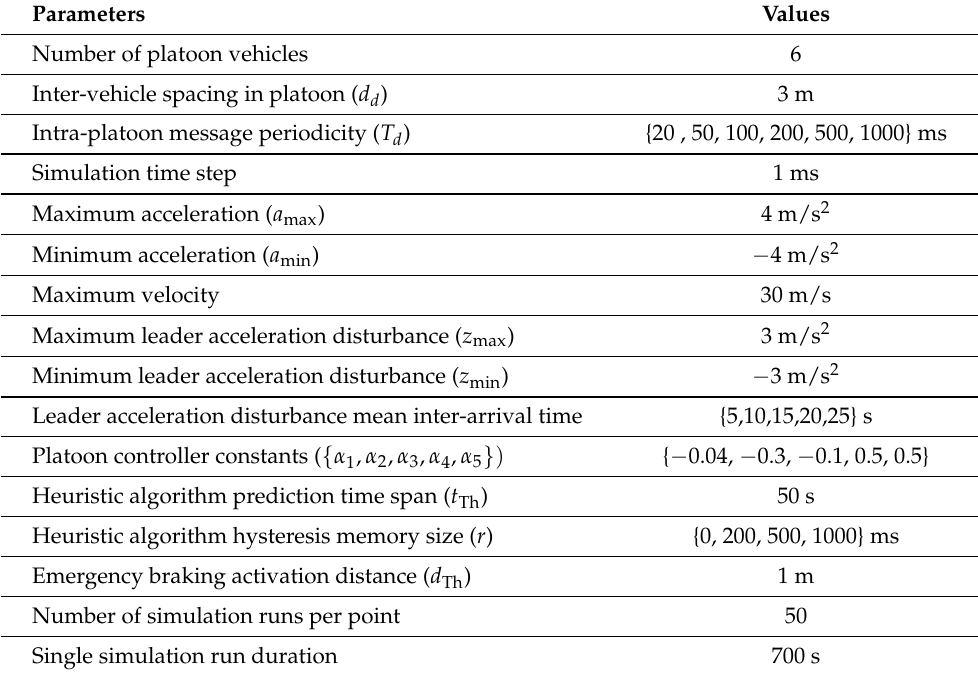
Table 1. Simulation